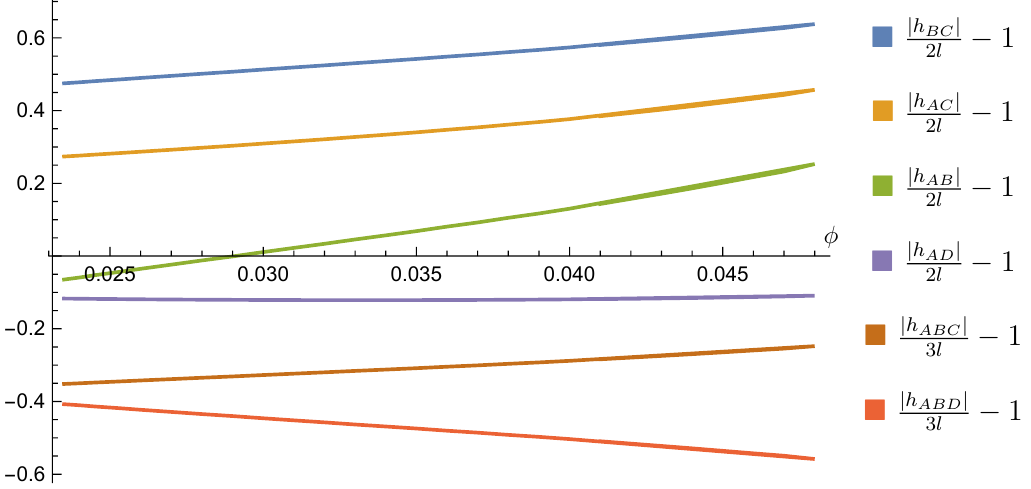
Figure 6 . The constraints (3.7) for the alternative handlebody ((cid:12)gure 5a) in the subspace where the connected and disconnected actions are